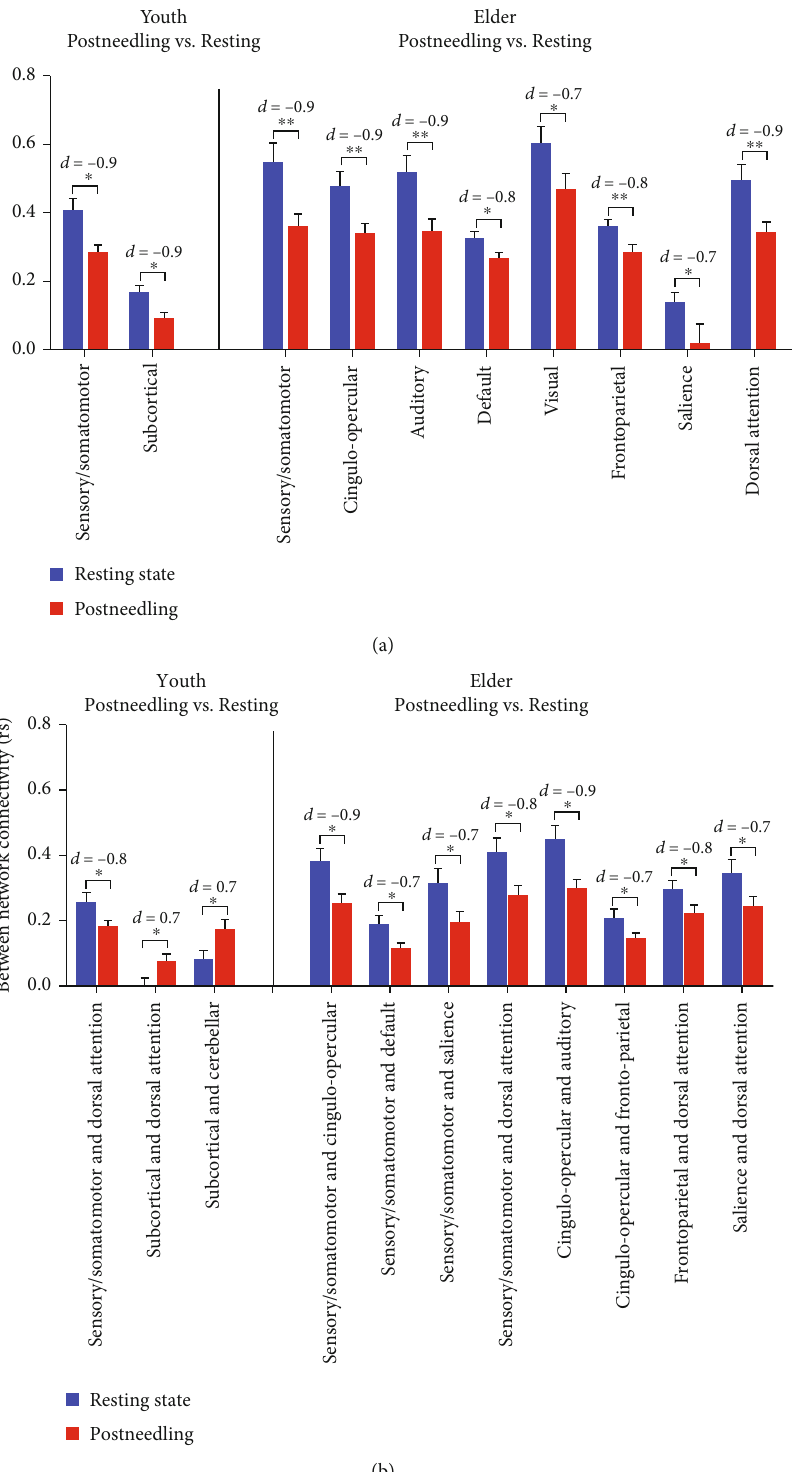
Figure 3: Average within and between subnetwork connections of fMRI in postneedling KI3 (red bar) compared with resting state (blue bar). (a) Average within network connections of subnetworks after needling KI3 compared to resting state in the youth group and the elder group. (b) Average between network connections of subnetworks after needling KI3 compared to resting state in the healthy youth group and the elder group. Those within or between subnetwork connections that showed no di ff erences were not displayed in the fi gure. ∗ P < 0 : 05 and ∗∗ P < 0 : 01 after FDR correction. The d value in upper part of the bars indicated Cohen ’ s d value, which depicted the e ff ect size of connections between two